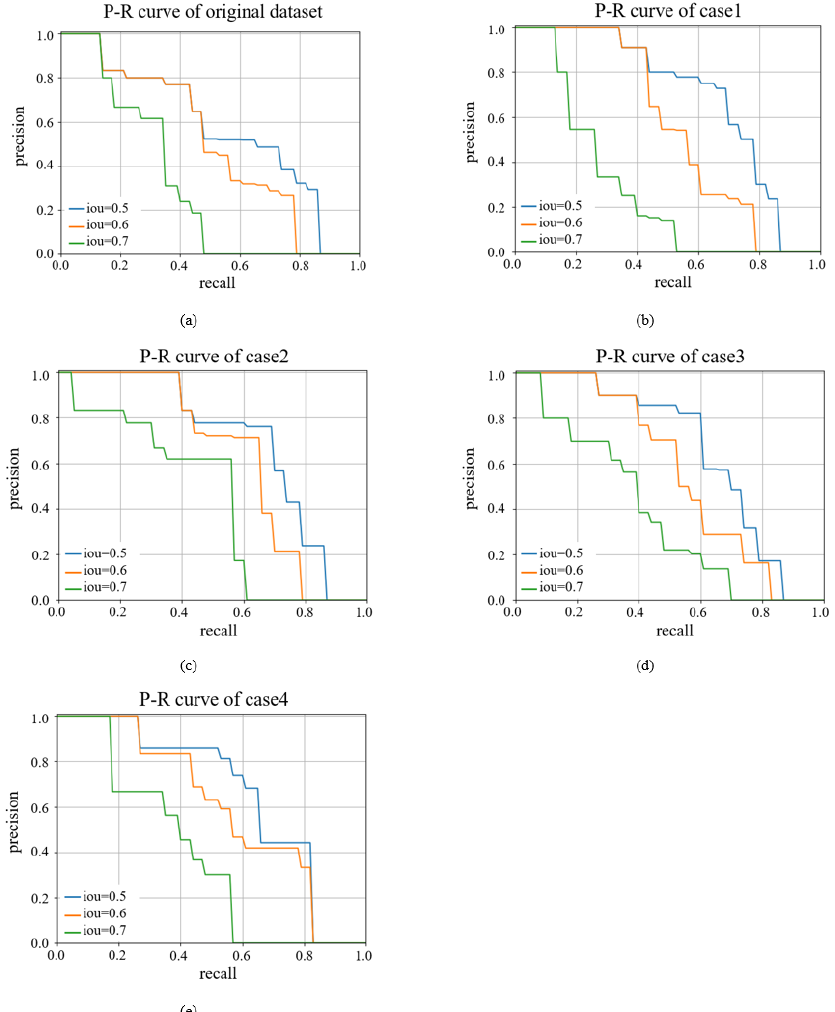
Figure 14. Precision–recall curve in bounding boxes using different methods. ( a ) Faster R ‐ CNN, ( b ) Faster R ‐ CNN +algorithm1, ( c ) Faster R ‐ CNN + algorithm2, ( d ) Faster R ‐ CNN + algorithm3, ( e ) Faster R ‐ CNN + algorithm4.